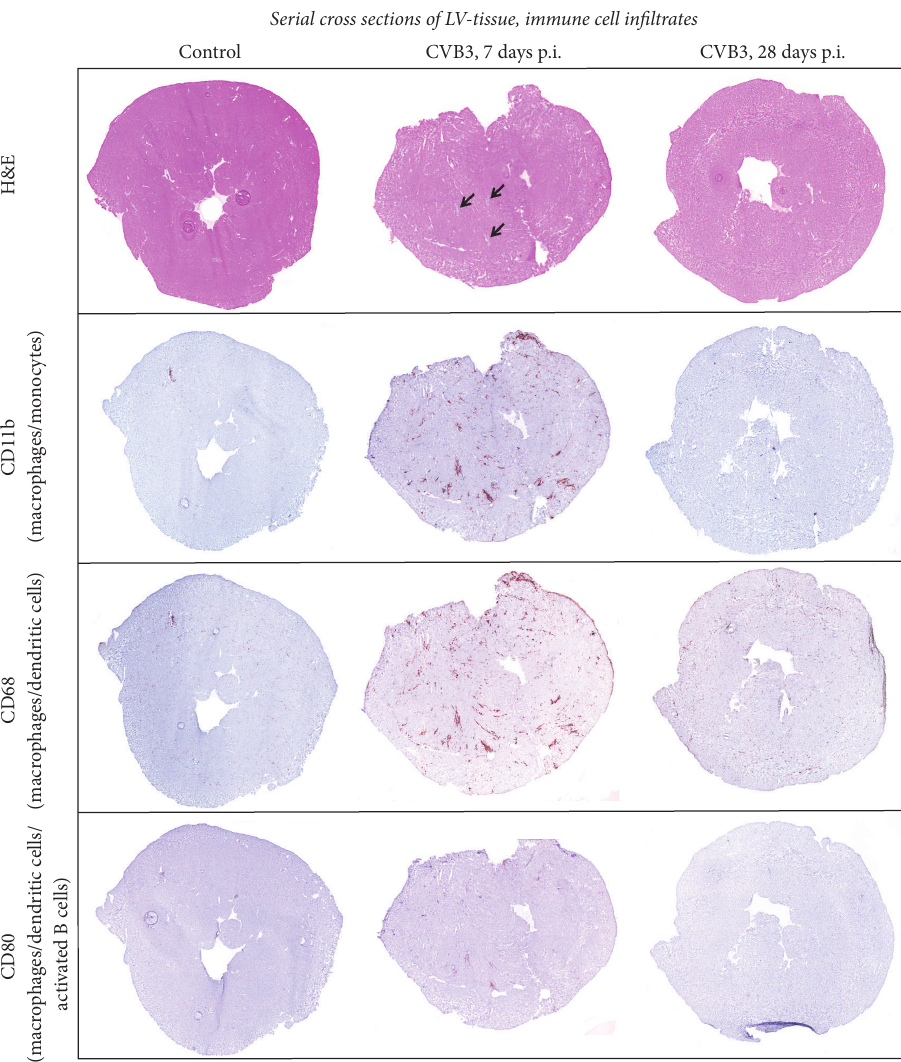
Figure 2: Immune cell infiltration: serial cross section of LVs from C57BL/6J mice without viral infection or 7 as well as 28 days after intraperitoneal CVB3 infection. Tissue sections were stained for various markers of inflammatory cells. Hematoxylin/eosin staining showed higher numbers of invaded cells to foci of inflammation 7 days after infection (indicated by arrows) compared to 28 days after infection. Increased numbers of CD80 + , CD11b + , and CD68 + cells are detected within the identified foci of inflammation 7 days after